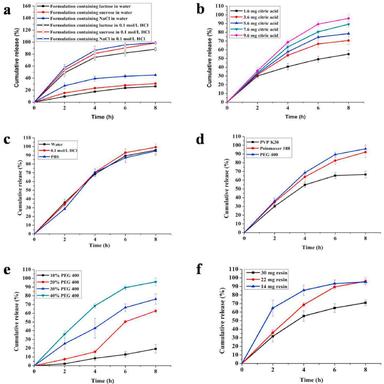
Cumulative release profiles for DR-CRS of HupA (n = 3). A: The effect of fillers on drug release. B: The effect of citric acid content on drug release. C: The cumulative release profiles of DR-CRS with citric acid as a filler in different release media. D: The effect of type of pore formers on drug release. E: The effect of PEG 400 contents on drug release. F: The effect of resin layer gain on drug release.